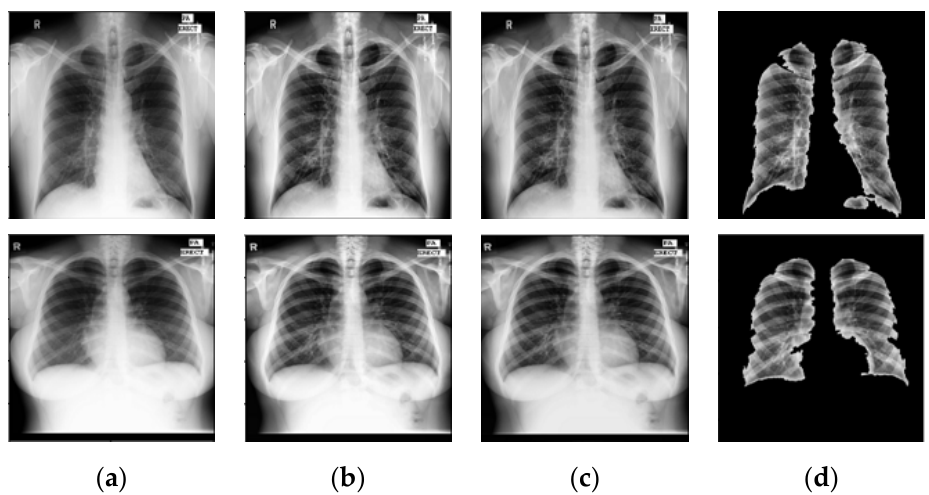
Figure 5. ( a ) Input Images—Normal; ( b ) Equalized images; ( c ) Weiner Filter; ( d ) Segmented images.